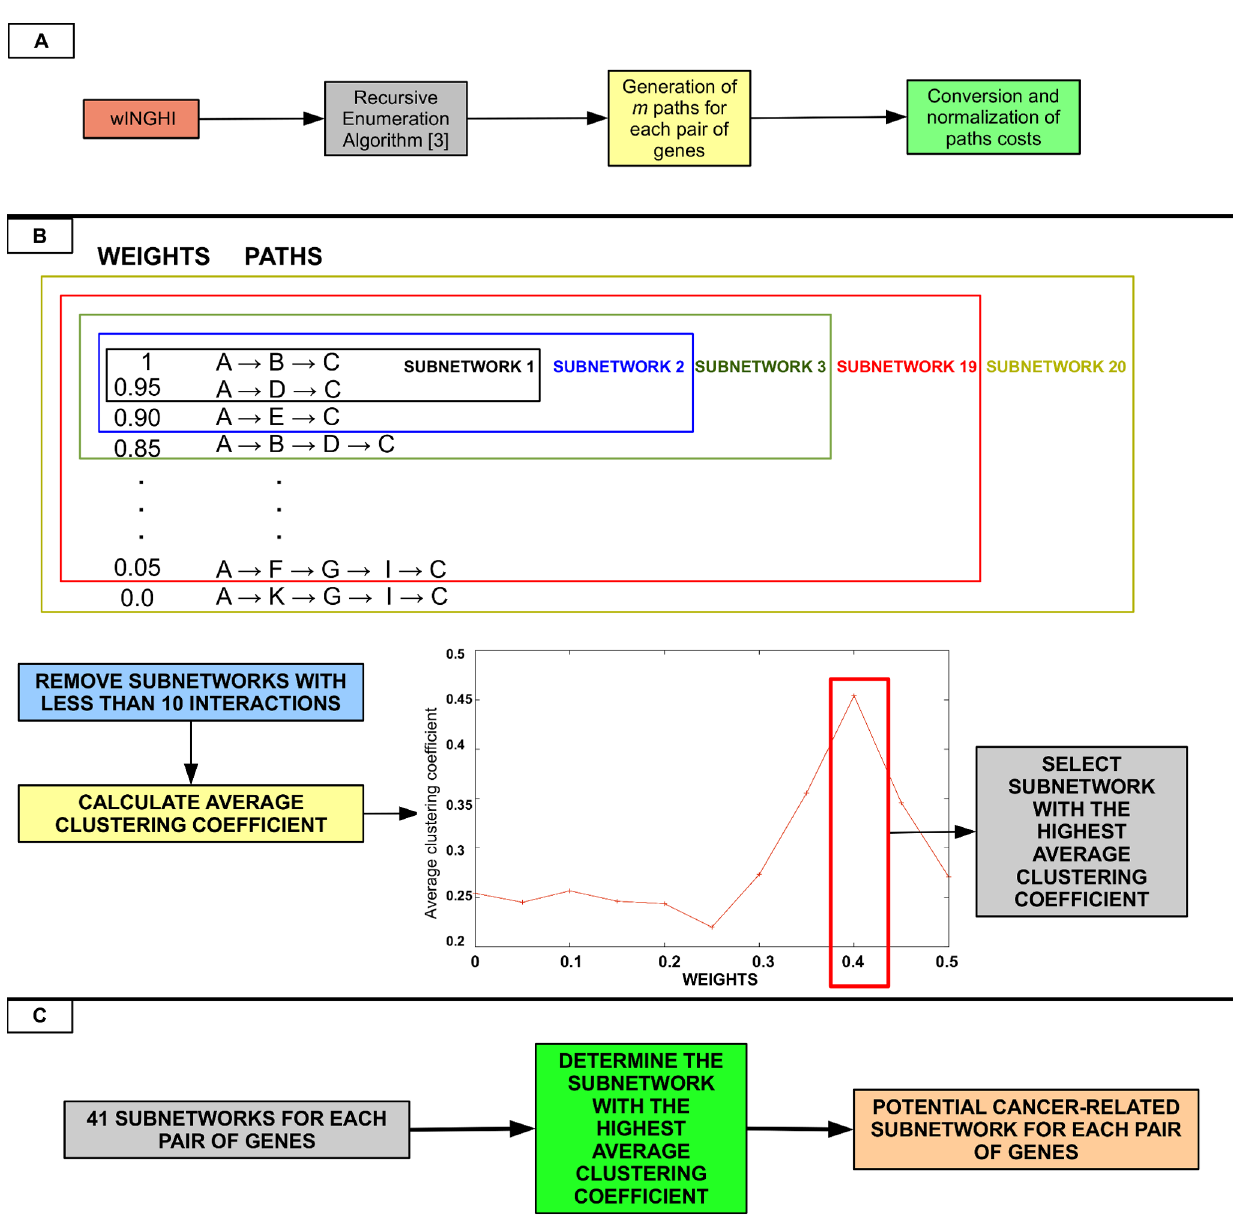
Figure 2. Final steps of graph2sig . ( A ) The application of REA on the wINHGI generates a list of m paths along with their costs for each pair of genes and these costs are converted to weights and normalized so that the minimum weight is zero and the maximum weight is 1. ( B ) Twenty subnetworks are generated from this list of paths and the subnetwork with the highest average clustering coefficient is selected. ( C ) For each pair of genes, 41 subnetworks are generated and, among these subnetworks, the one with the highest average clustering coefficient is selected as the final potential cancer-related subnetwork.